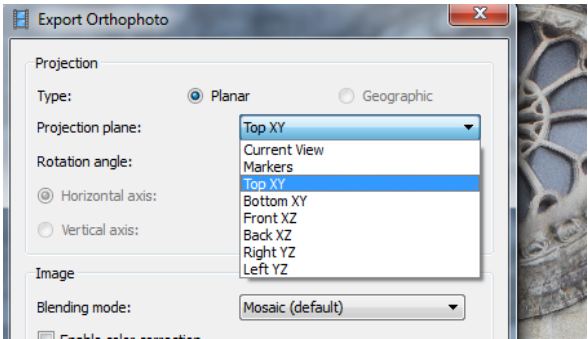
Figure 18. “PhotoScan Pro” Export Orthophoto window.